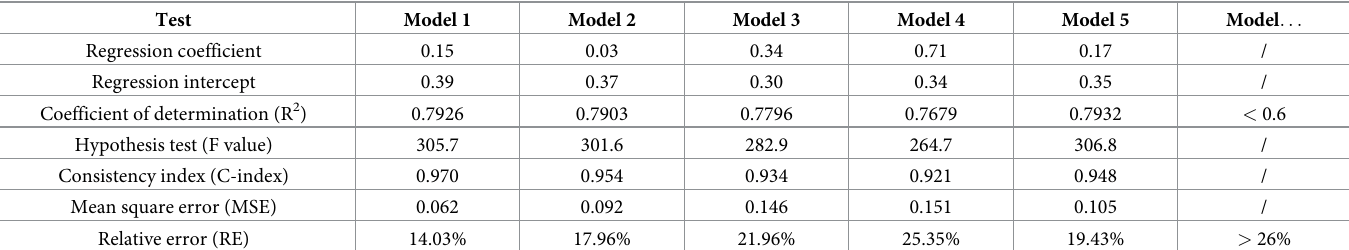
Table 2. Results of the accuracy analysis and error verification for the various models.